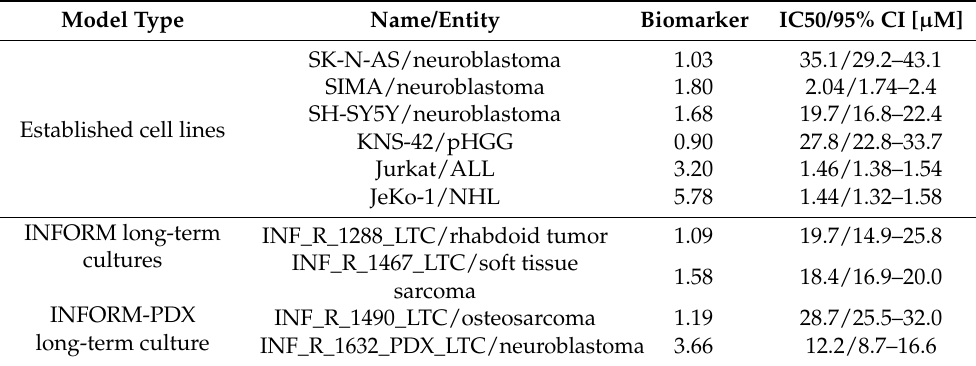
Table 4. Biomarker validation in ten randomly picked samples (>1.0 predicts sensitivity; sensitivity is defined as IC50 < 20 µ